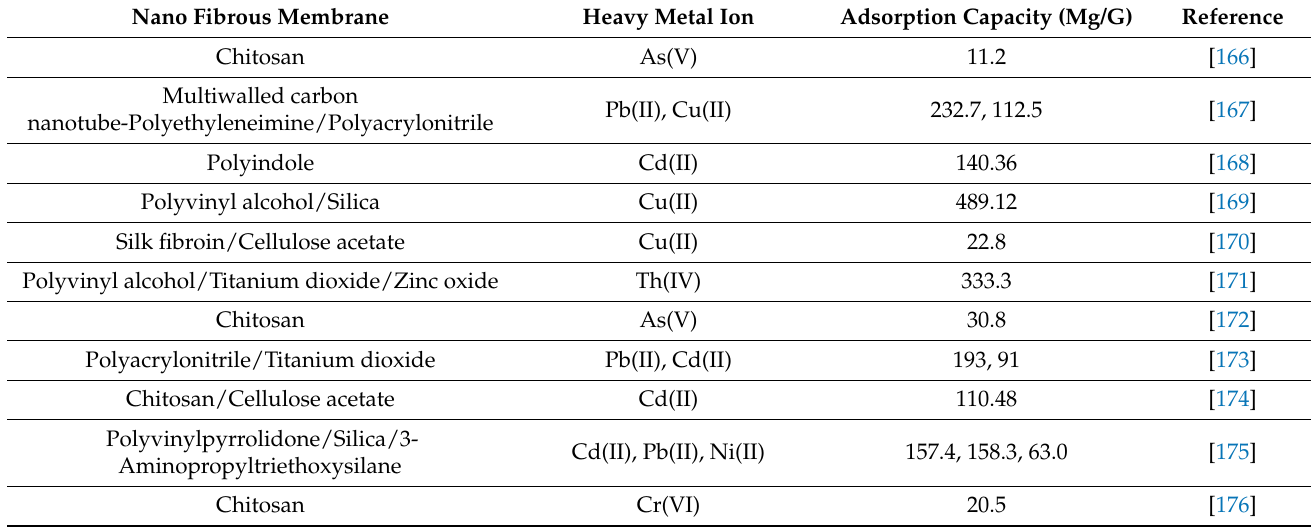
Table 8. Application of various nanofibrous membranes in the removal of heavy metals from water for water